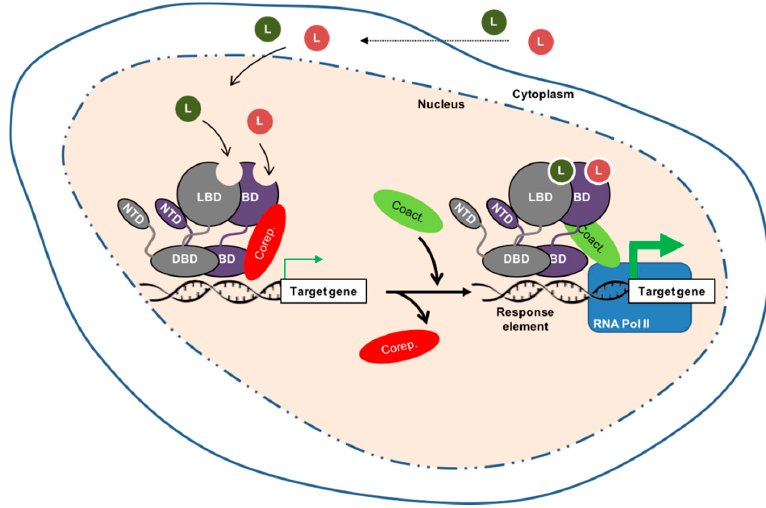
Figure 2. Schematic structure and functioning of nuclear receptors bound as heterodimers with retinoid X receptors (RXR). The non-steroid nuclear receptor (grey) is supposed to be bound with RXRs, a receptor for 9- cis retinoic acid (deep purple), to the DNA. In absence of ligand, the transcriptional activity is blocked (thin green arrow) by co-repressors (Corep.). As for the steroid receptors, the binding of co-activators (Coact.) makes possible the recruitment of the transcriptional machinery, along with the RNA polymerase II (RNA Pol II), the transcription of the target gene (thick green arrow), and the physiological effects.